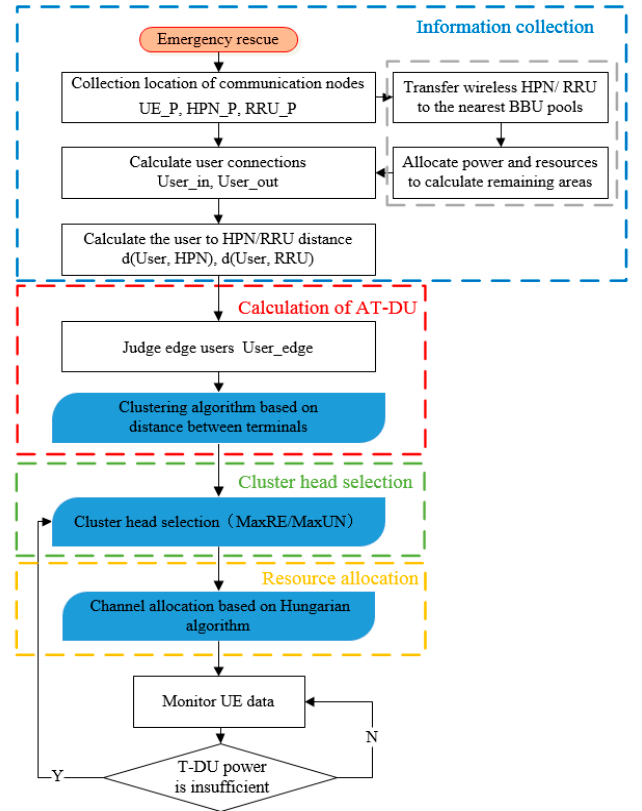
Figure 3. The process of D2D multicasting emergency communications.